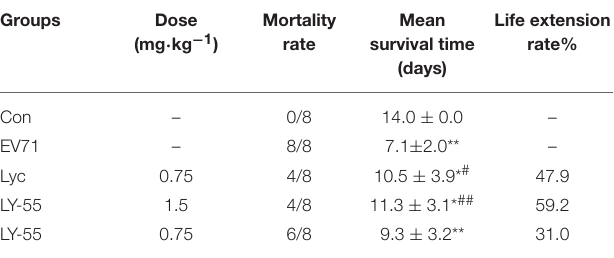
TABLE 2 | Impact of treatment with drugs on mortality rates and mean survival time of mice infected with EV71-H-MA.